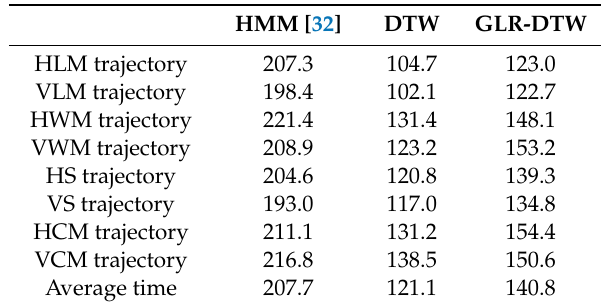
Table 4. The comparison of time complexity